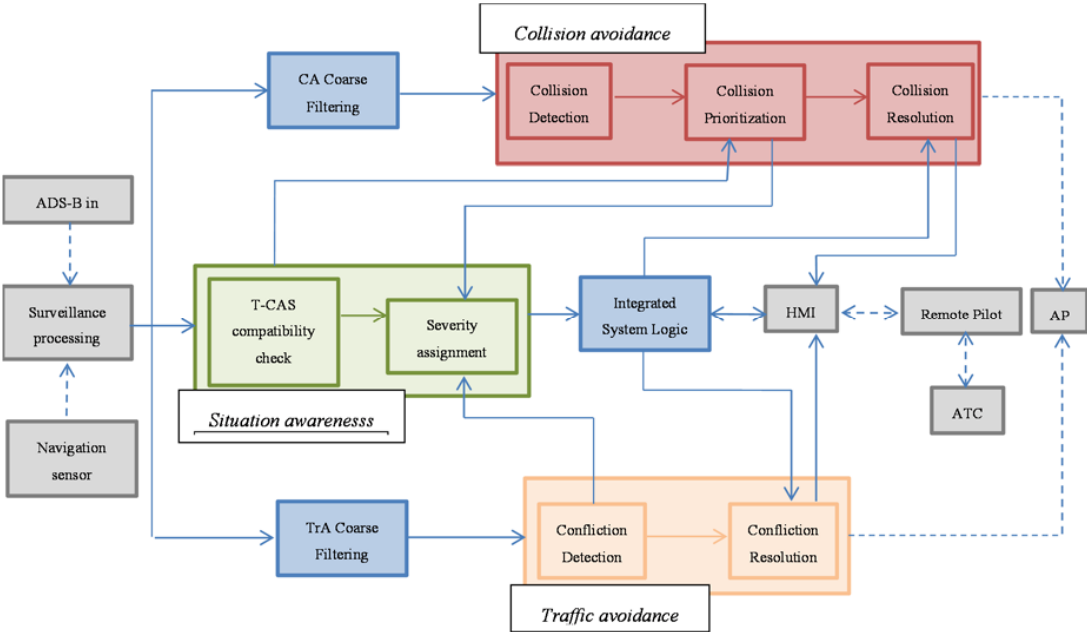
Figure 2. Overall DAA system functional architecture tested during RAID flight sorties (from [18]); it contains public sector information licensed under the Open Government Licence v3.0, see [22].